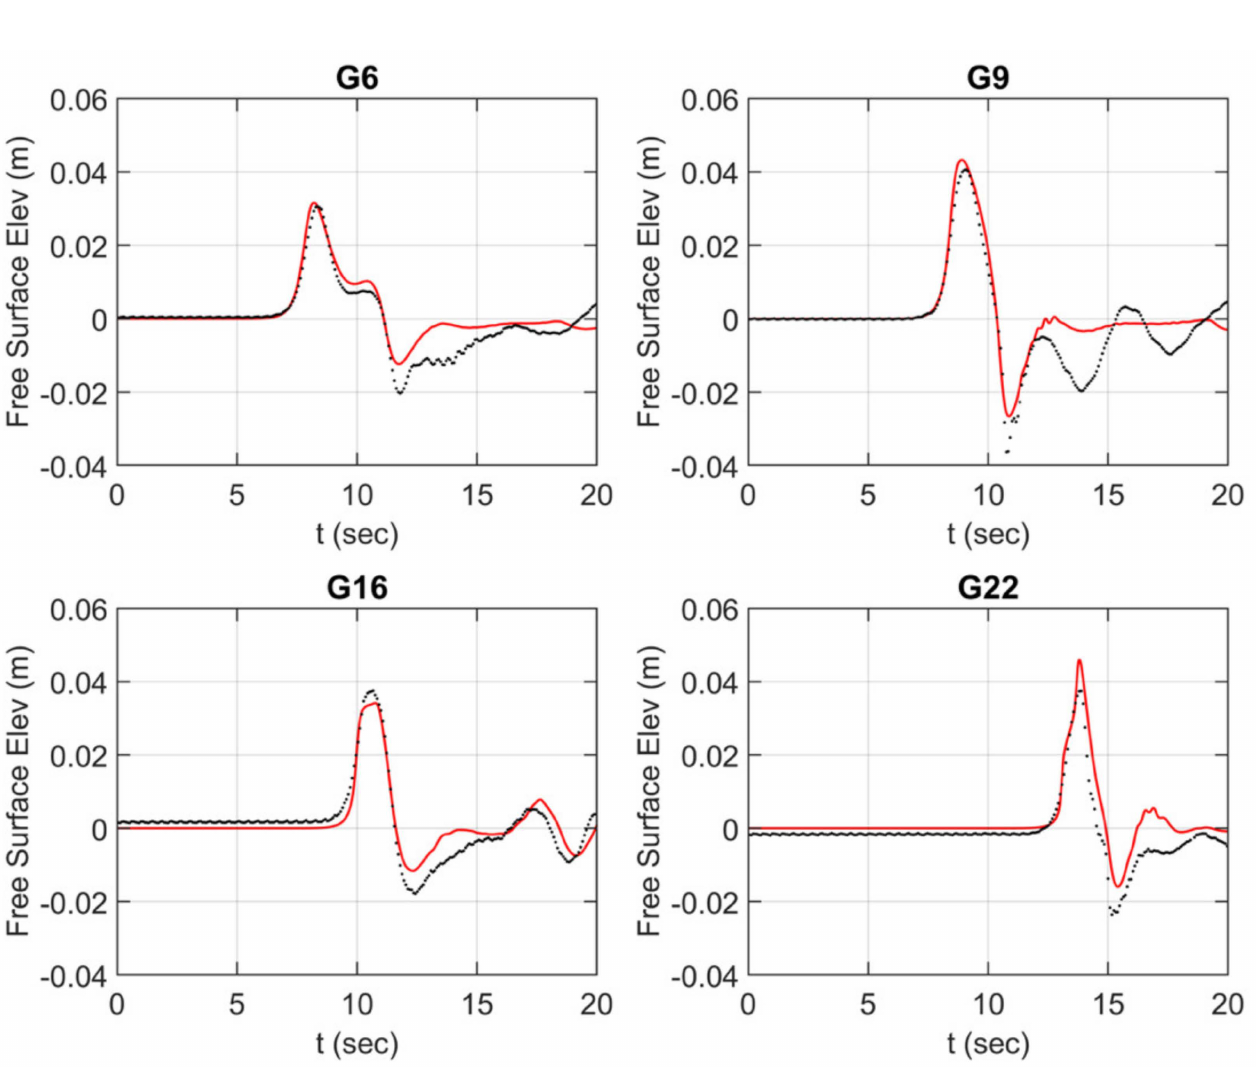
Figure 7. Comparisons between the computed free surface elevations (red lines) and measured water levels (black dots) (A/h = 0.091) at wave gauges G6, G9, G16, and G22, respectively. The wave gauge locations can be found in Table